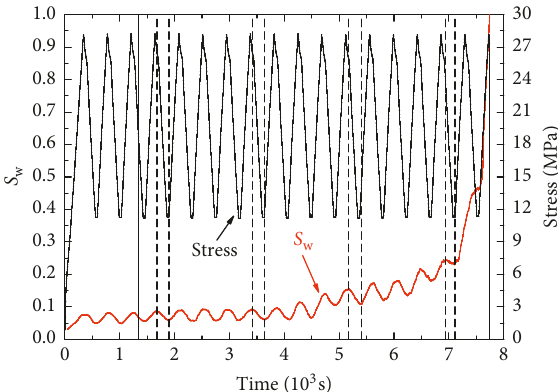
Figure 7: Contrast curve of S